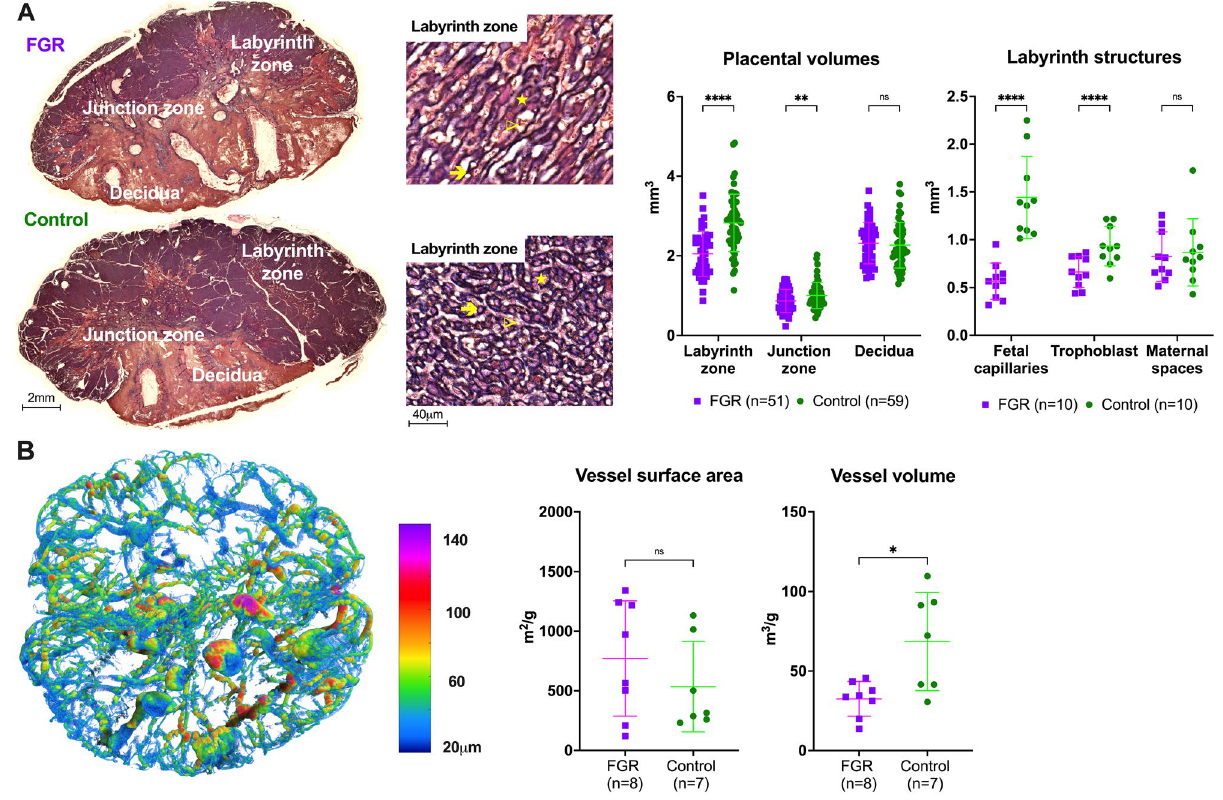
Figure 1. Placental histology and microcomputed tomography. ( A ) Placentas with cytokeratin/lectin double staining, divided by placental zones (left images). Within the labyrinth (zoomed, right), fetal capillaries (arrow), maternal blood spaces (arrowhead) and trophoblast (star) were grid counted to calculate relative and absolute volume densities. For placental volumes, 51 FGR and 59 control placentas were used from 20 litters. For labyrinth structures, 10 FGR and 10 control placentas were used from 10 litters (1 placenta per horn, per litter). ( B ) Representative image of a placental microcomputed tomography after color coding according to vessel diameter. Data were analysed using a linear mixed-effects model and displayed as mean ± SD with significance as *0.05 ≥ p > 0.01; **0.01 ≥ p > 0.001.; ***0.001 > p > 0.0001; ****p <